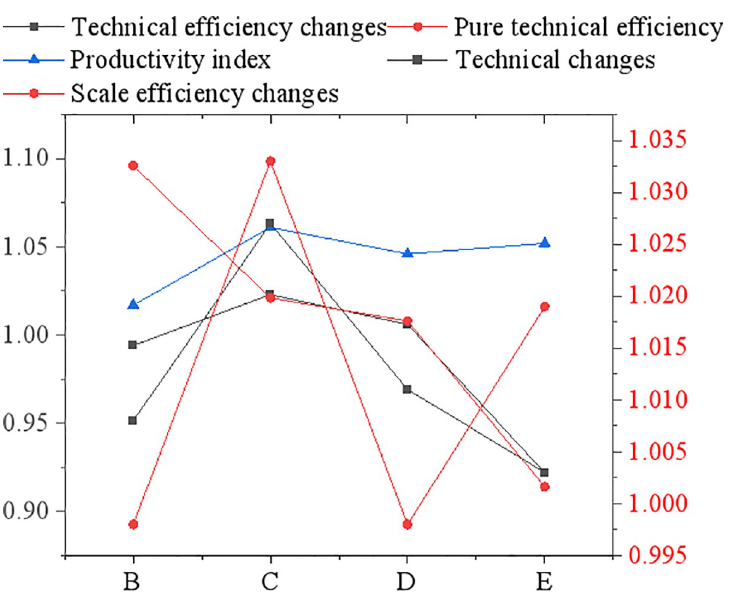
Fig 10. Dynamic efficiency changes of high-tech IDZs across China in different years.